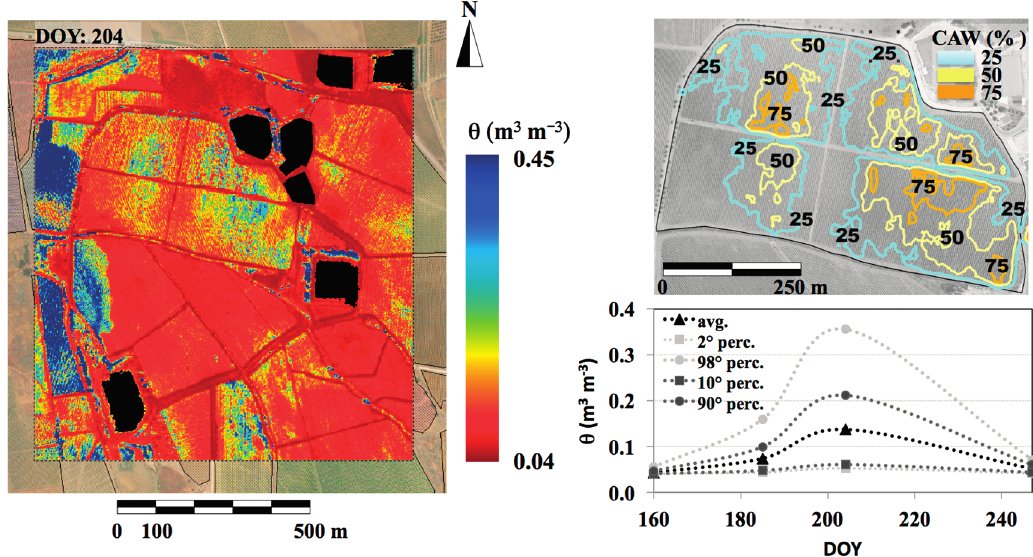
Figure 8. Spatial distribution of θ for the DOY exhibiting the higher spatial variability (DOY 204, left panel) and current percentage of available water to the plant roots (upper-right panel); θ statistics (2nd, 10th, 90th, 98th percentiles and average spatial values) for the whole time series (lower-right